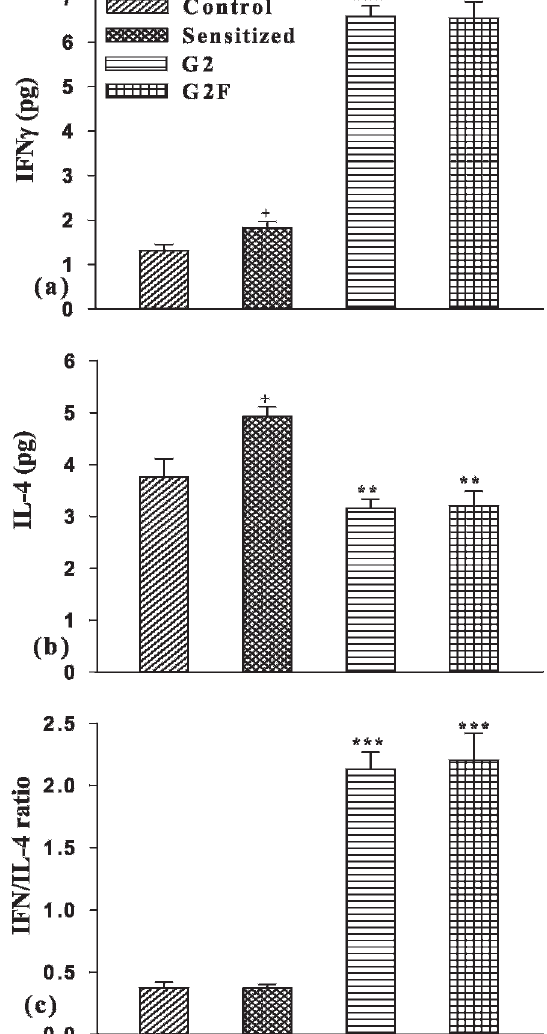
Figure 3 - Serum levels of IFN- c (a), IL-4 (b) and IFN- c -to-IL-4 ratio (c) in control, sensitized (S), S treated with adjuvant G2 (S + G2) and S treated with adjuvant G2F (S + G2F) guinea pigs (for each group, n=7). Significant differences between the control and sensitized group: + ; p , 0.05. Significant differences between the S + G2 and S + G2F groups vs the S group: **; p , 0.01, ***; p , 0.001. There was no significant difference between the S + G2 and S +